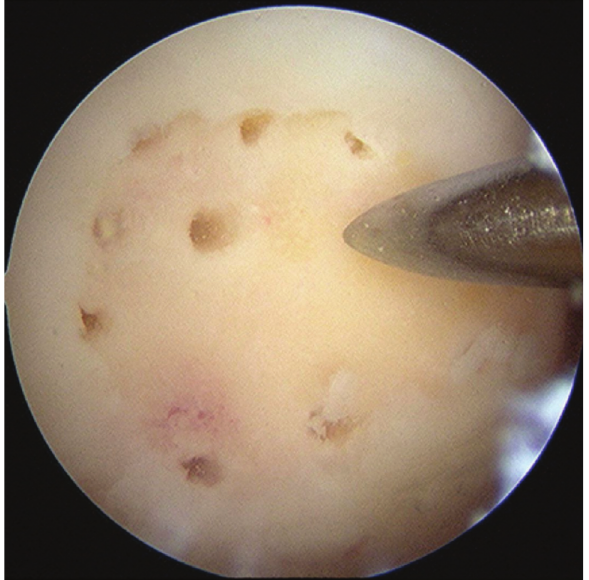
Fig. 2: Arthroscopy image. Microfracture of the cartilage defect after preparation of the base.